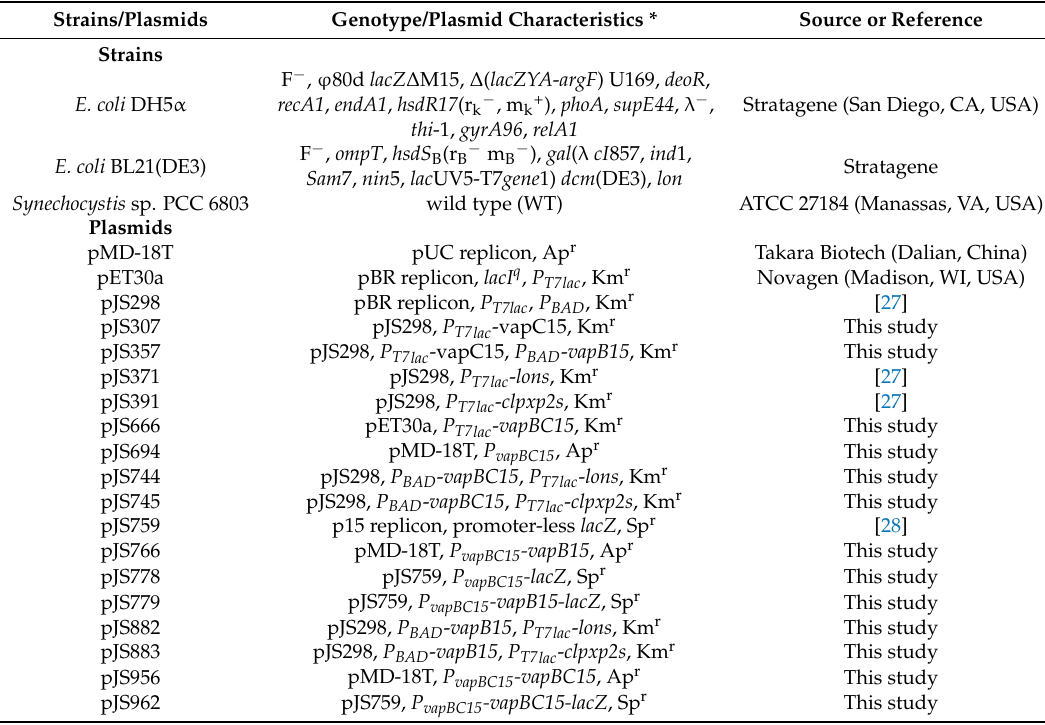
Table 1. Strains and plasmids used in this